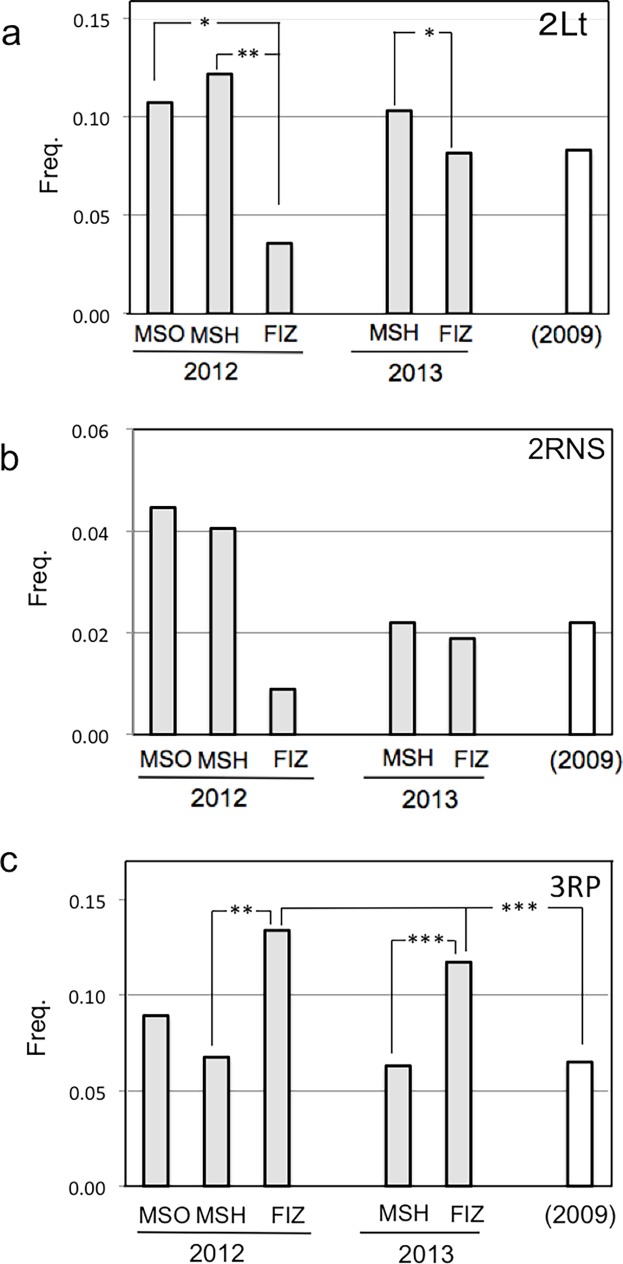
Frequencies of common cosmopolitan inversions in Fukushima.(a) In(2L)t, (b) In(2R)NS and (c) In(3R)P. Data of 2009 are cited from the previous report [46]. Significance of difference in Chi square test are depicted by * (p < 0.05), ** (p < 0.01), or *** (p < 0.001).